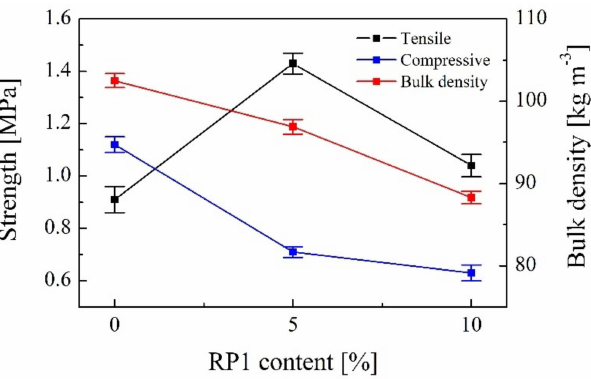
Figure 9. Tensile strength, compressive strength and bulk density according to RP1